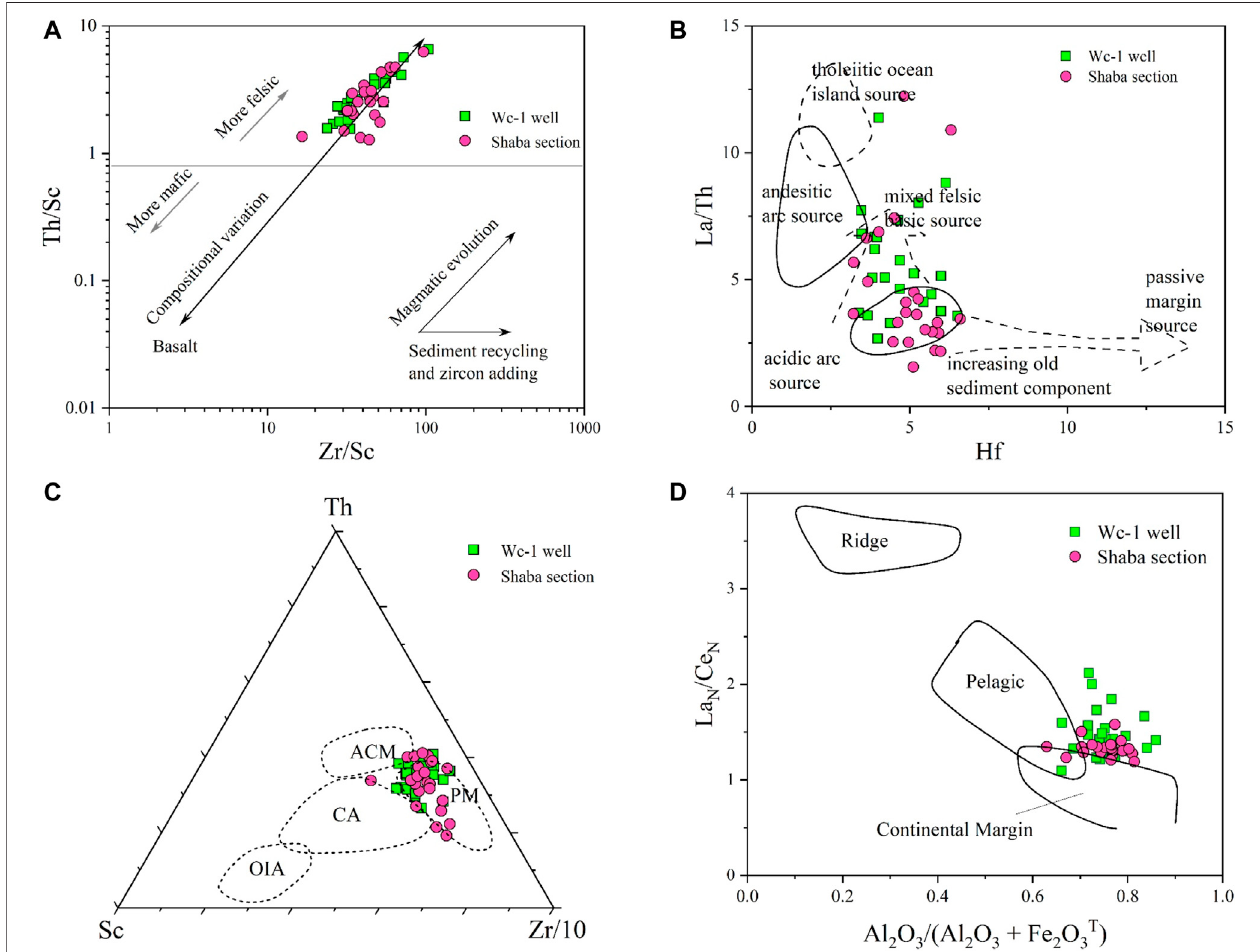
FIGURE5| SedimentaryprovenanceandtectonicsettingdiscriminationdiagramsforWc-1wellandShabasectionsamples. (A) Zr/Sc — Th/Sc, (B) Hf — La/Th, (C) Th — Sc — Zr/10 ternary diagram, and (D) Al 2 O 3 /(Al 2 O 3 + Fe 2 O 3T ) — La N /Ce N . ACM: active continental margin. CA, continental island arc; PM, passive margin; And OIA, oceanic island arc.